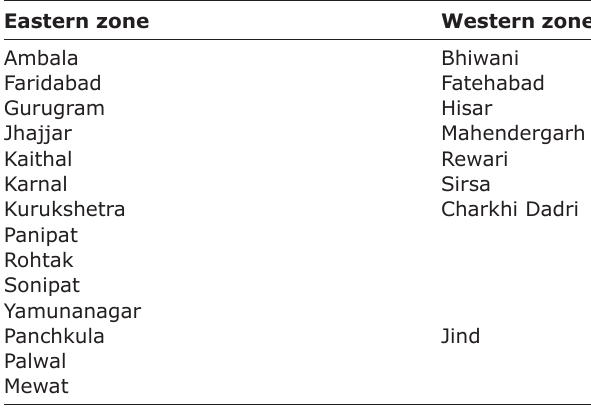
Table-2: List of districts in different agroclimatic zones of Haryana.